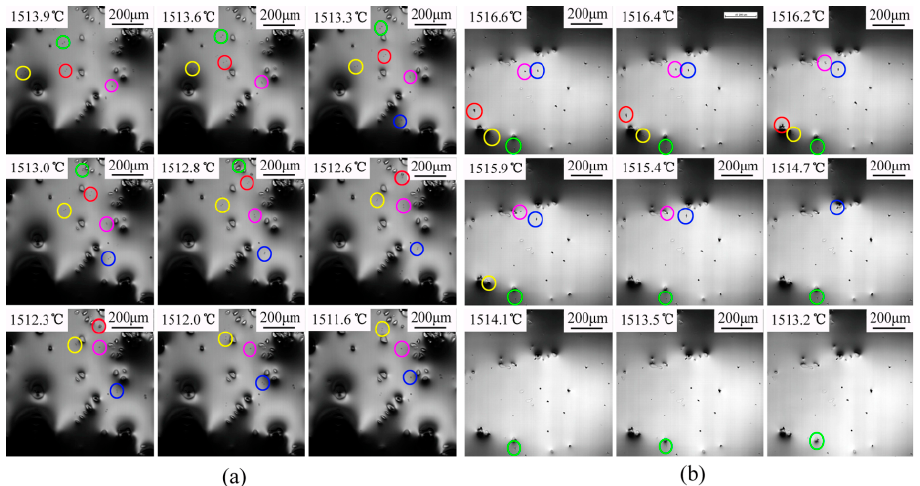
Figure 4. Dynamic behavior of particle motion in nine consecutive time cells ， and the tracked in- clusions with five colored circles ( a ) without PMF and ( b ) with PMF.